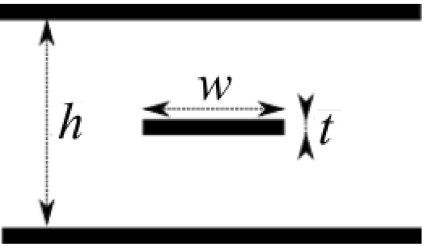
Figure 1. Cross-section schematic for the stripline geometry, showing width of central conductor, w , thickness of central conductor, t , and height of stripline cavity, h .